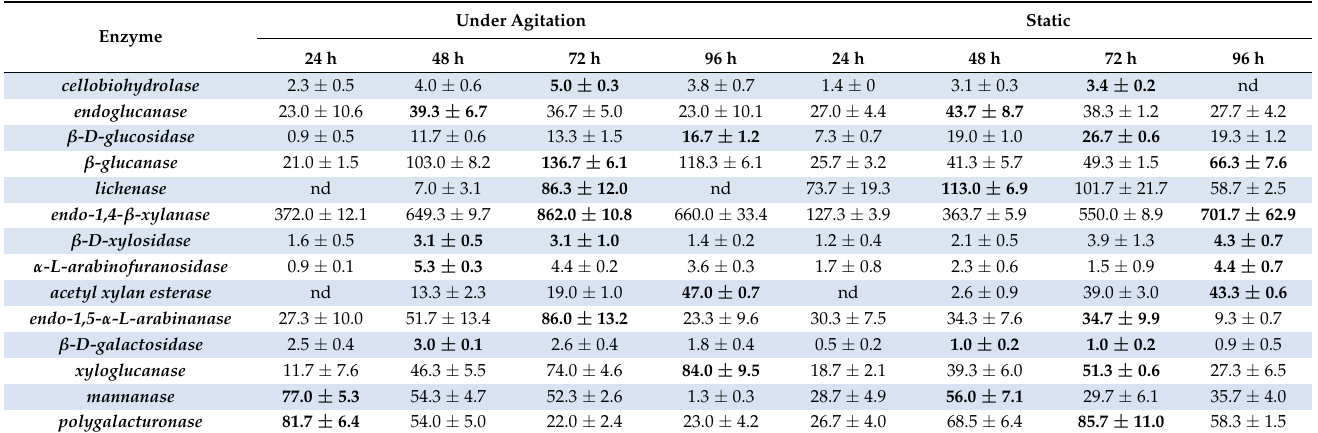
Table 2. Enzymatic activities of Thermothelomyces thermophilus LMBC 162 cultivated with tamarind seeds during differ- ent